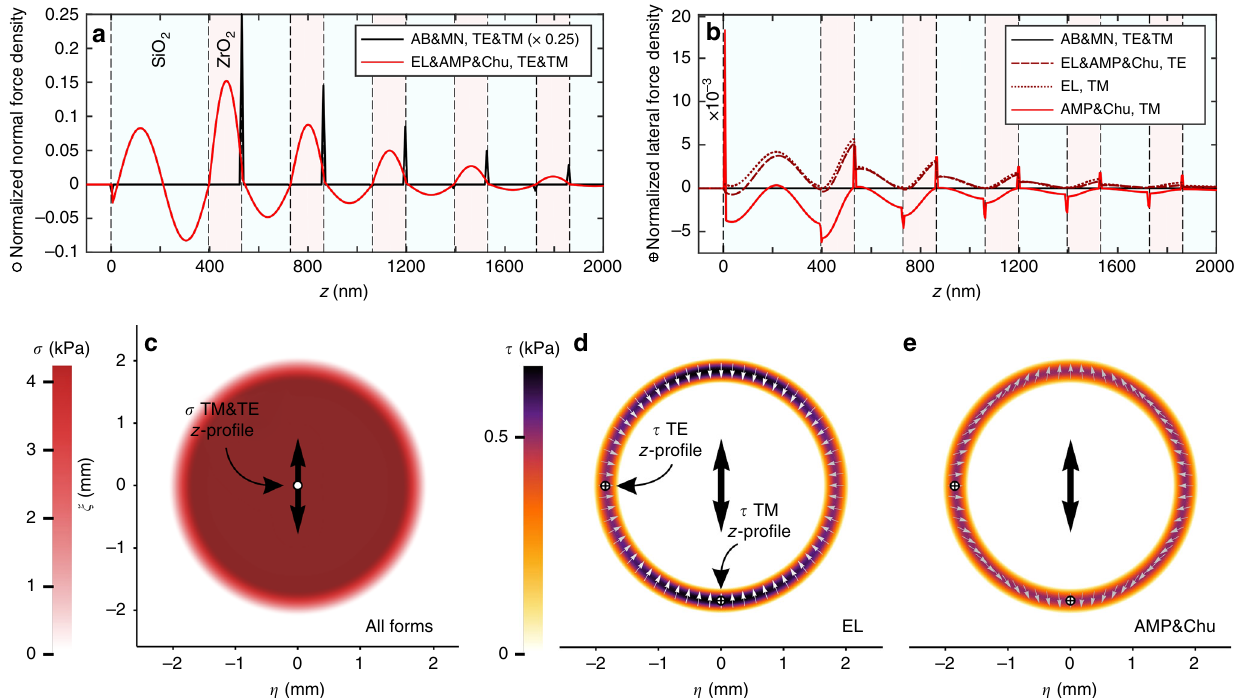
Fig. 3 Peak force densities and stresses in the HR coating. Simulated light-matter momentum transfers in the HR coating layers and time-average peak normal σ and lateral stress τ acting on the illuminated surface of the mirror. a The calculated z -distribution of the peak normal force density along the beam axis for all formalisms and both, the TE and the TM polarizations. The AB and MN force densities are degenerate and localized at interfaces, where a push is predicted at the interface of ZrO 2 /SiO 2 , and a pull at the boundary of SiO 2 /ZrO 2 . The EL, AMP, and Chu force densities are also degenerate and continuously distributed throughout the bulk. b shows the z -pro fi les of the peak lateral force density within the grating for the TE and the TM illumination at the corresponding maximum slopes of the beam ’ s spatial pro fi le. In addition to the continuously distributed lateral force density throughout the bulk, the degenerate AMP and Chu formulations also yield interface contributions. The presented force densities are normalized by the maximum value calculated by the AB and MN formalism. Utilizing such z -pro fi les, the surface-projected normal σ ( c ) and lateral stresses τ ( d , e ) are constructed and later used as source terms in the FEM and GFF wave propagation analysis. The spatial distribution of the normal stress (radiation pressure) has the same shape as the spatial pro fi le of the laser beam and is independent of the polarization and formalism used. Its peak value is 4.24 kPa. The lateral stress-electrostriction has a nonzero value only at points in the laser beam pro fi le where the illumination transitions down from the central uniform plateau. It is dependent both on the direction of polarization (the large arrow marks the oscillation direction of the electric fi eld) and on the chosen electrodynamic formalism. Perpendicularly to the direction of polarization (TE), the maximum magnitude of the shear stress is 0.51 kPa (EL, AMP, and Chu), while along the direction of polarization (TM), it is 0.50 kPa (AMP and Chu) and 0.67kPa (EL). AB and MN formalisms do not account for electrostriction forces. The EL